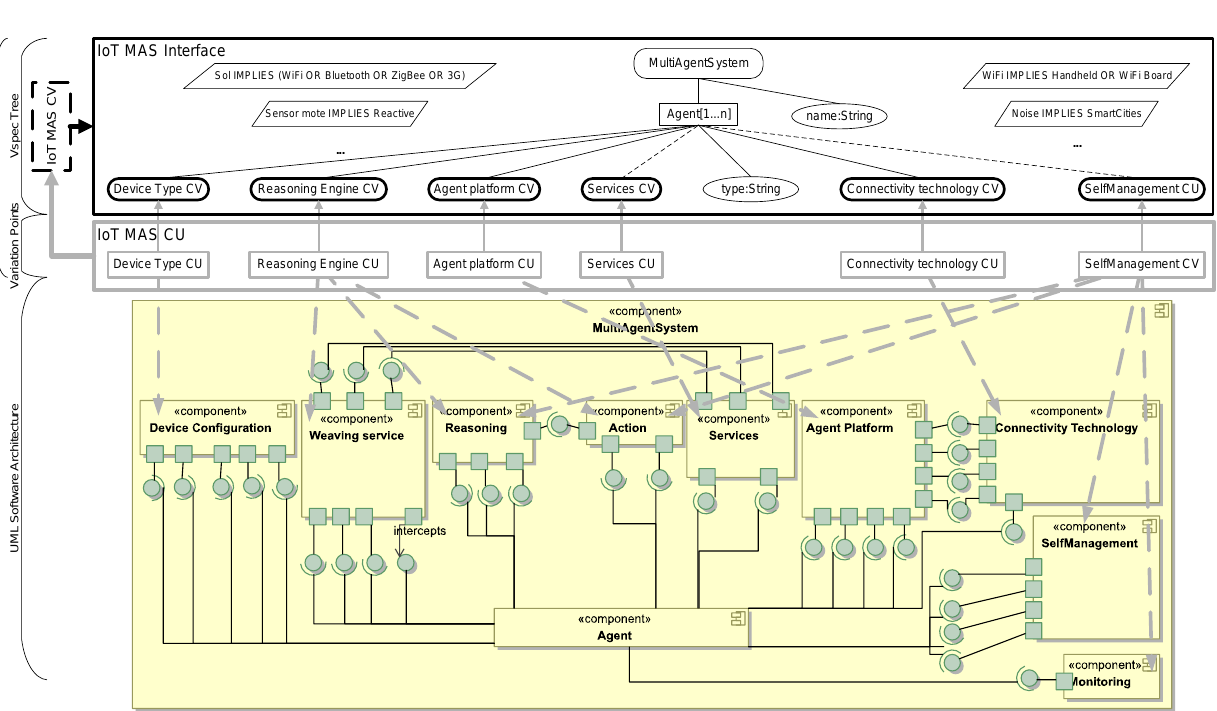
Figure 3. Complete variability model of the multi-agent system for the IoT in